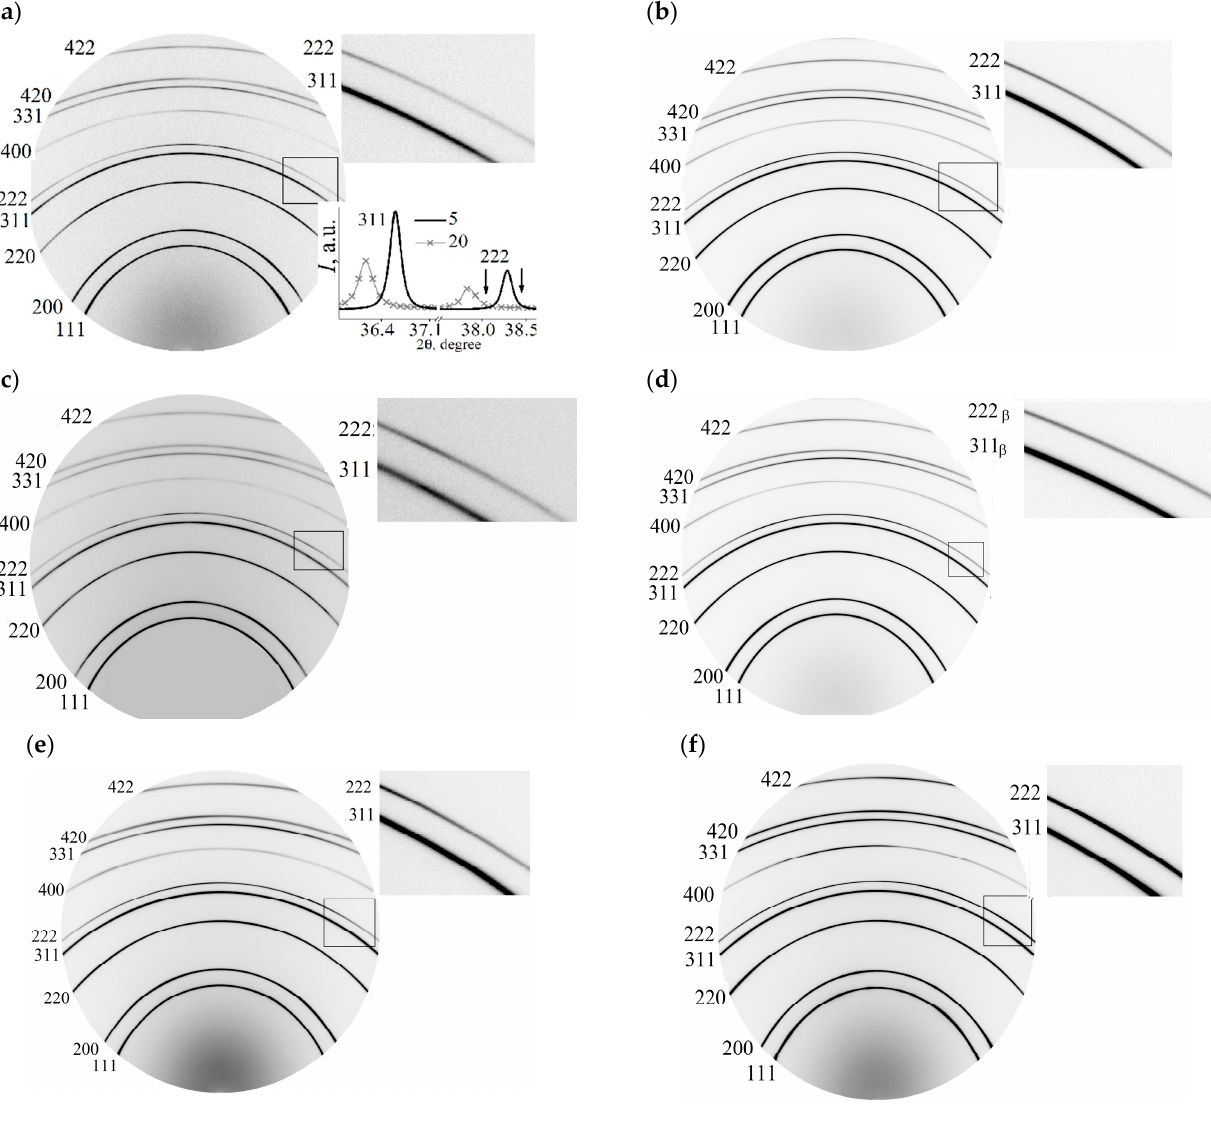
Figure 1. Diffractograms of membranes with a lead content of 5 and 20 wt.% for the states: ( a , b )—before hydrogenation; ( c , d )—24 h relaxation after hydrogenation; ( e , f )—5300 h relaxation after hydrogenation, respectively.